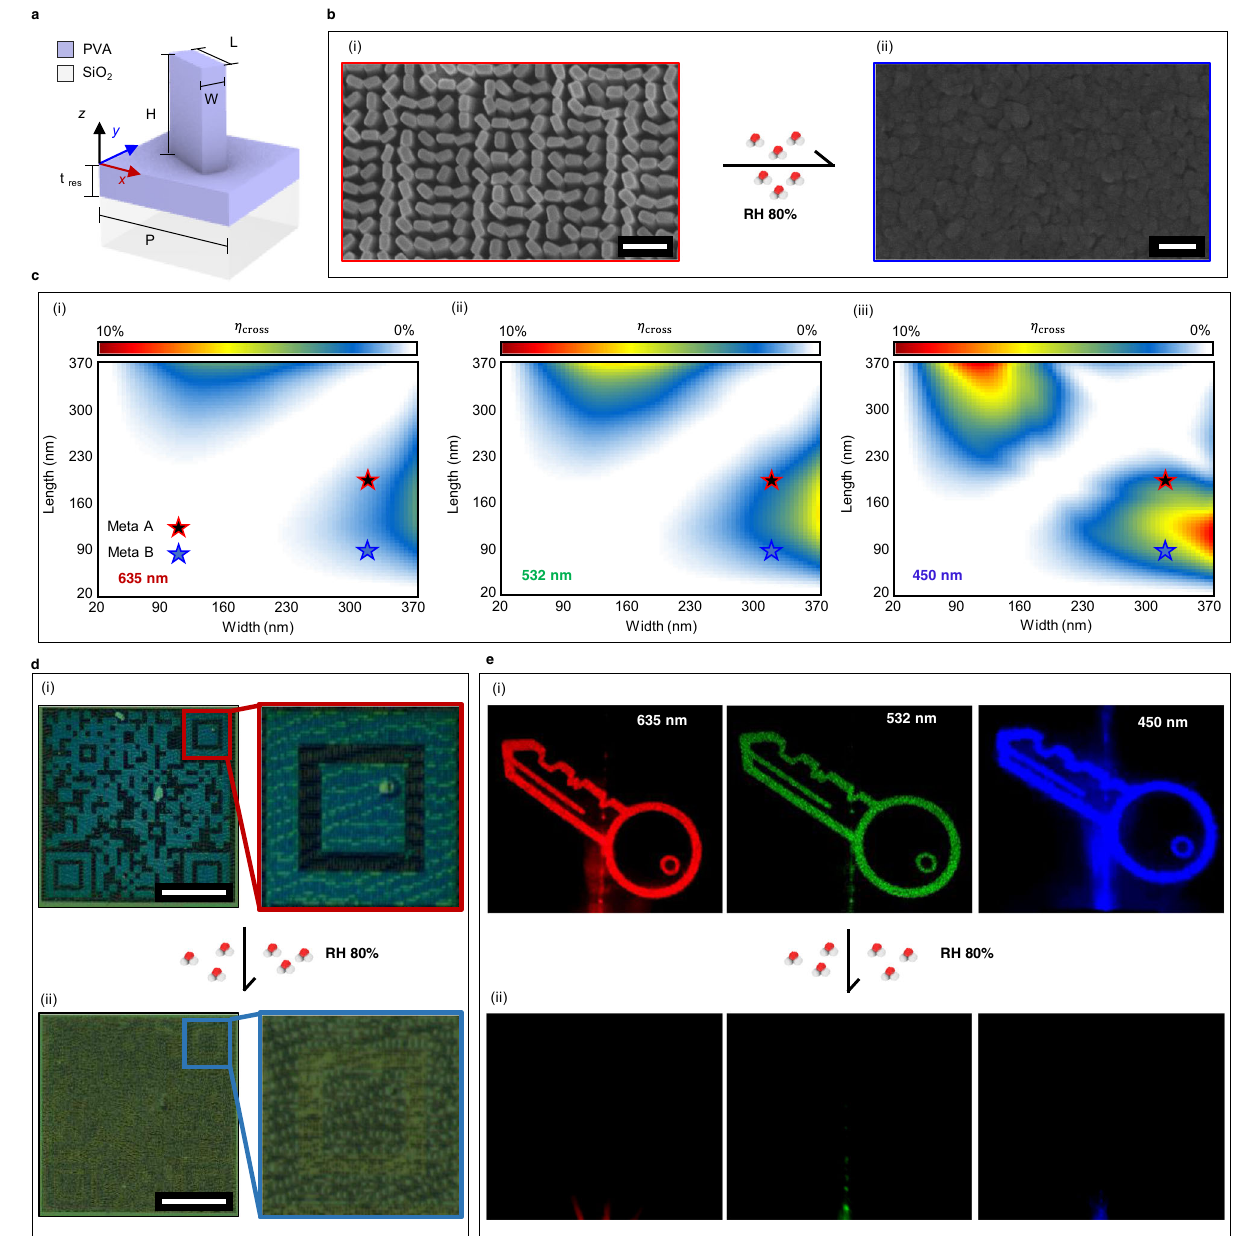
Fig. 3 | Polyvinyl alcohol metasurfaces for multiplexed structural color and metaholography forhumiditysensitive smart labels. a Schematicillustrationof the polyvinyl alcohol (PVA) meta-atom for humidity sensitive smart labels. b Scanning electron microscope (SEM) images of the PVA metasurface (i) before and(ii)afterexposuretorelativehumidity(RH)80%conditions.Scalebars:(i)1 µ m, (ii)100nm. c Calculated cross-polarization ef fi ciencies atthe working wavelengths of(i)635,(ii)532,and(iii)450nm.Twometa-atoms(denotedasMetaAandMetaB) areselected.Periodicity( P )andheight( H )are fi xedat400and500nm. d Re fl ected